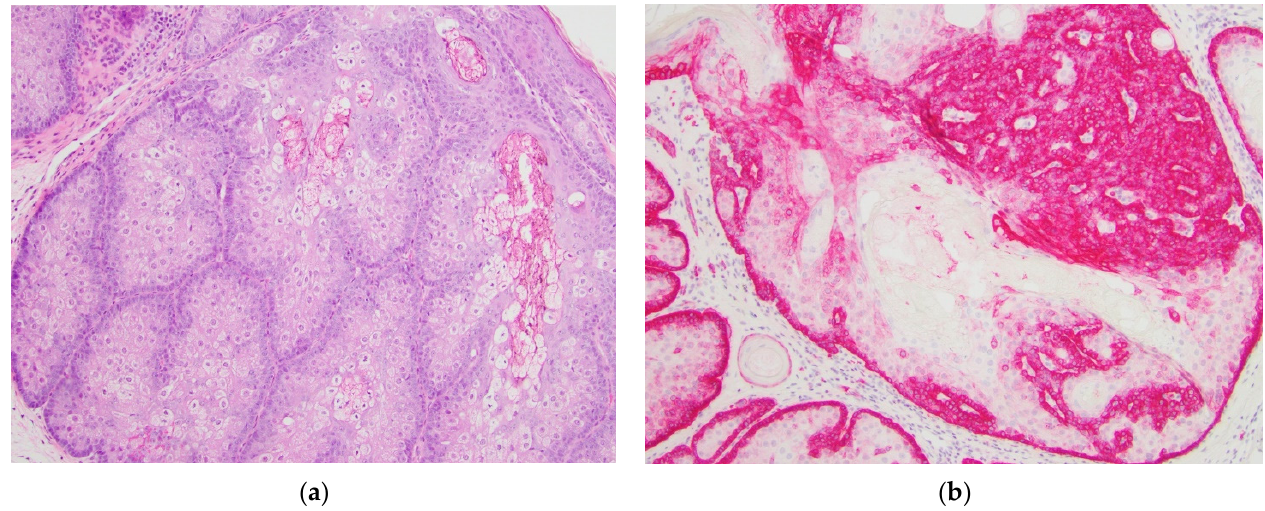
Figure 3. Sebaceous adenoma, sample case. ( a ) Hematoxylin and eosin-stained section showing a well-circumscribed dermal-based tumor consisting predominantly of mature sebocytes with a basaloid component comprising less than 50% of the tumor cells. Cytologic atypia and mitoses are not prominent, original magnification 100×; ( b ) GLUT1 immunohistochemical stain of the same tumor showing cytoplasmic and membranous staining in the basaloid component of the tumor with weak to absent staining in mature sebocytes, original magnification 100×.